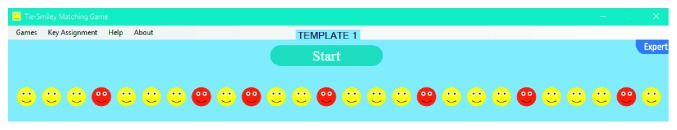
Initial form of TSMG in template 1.